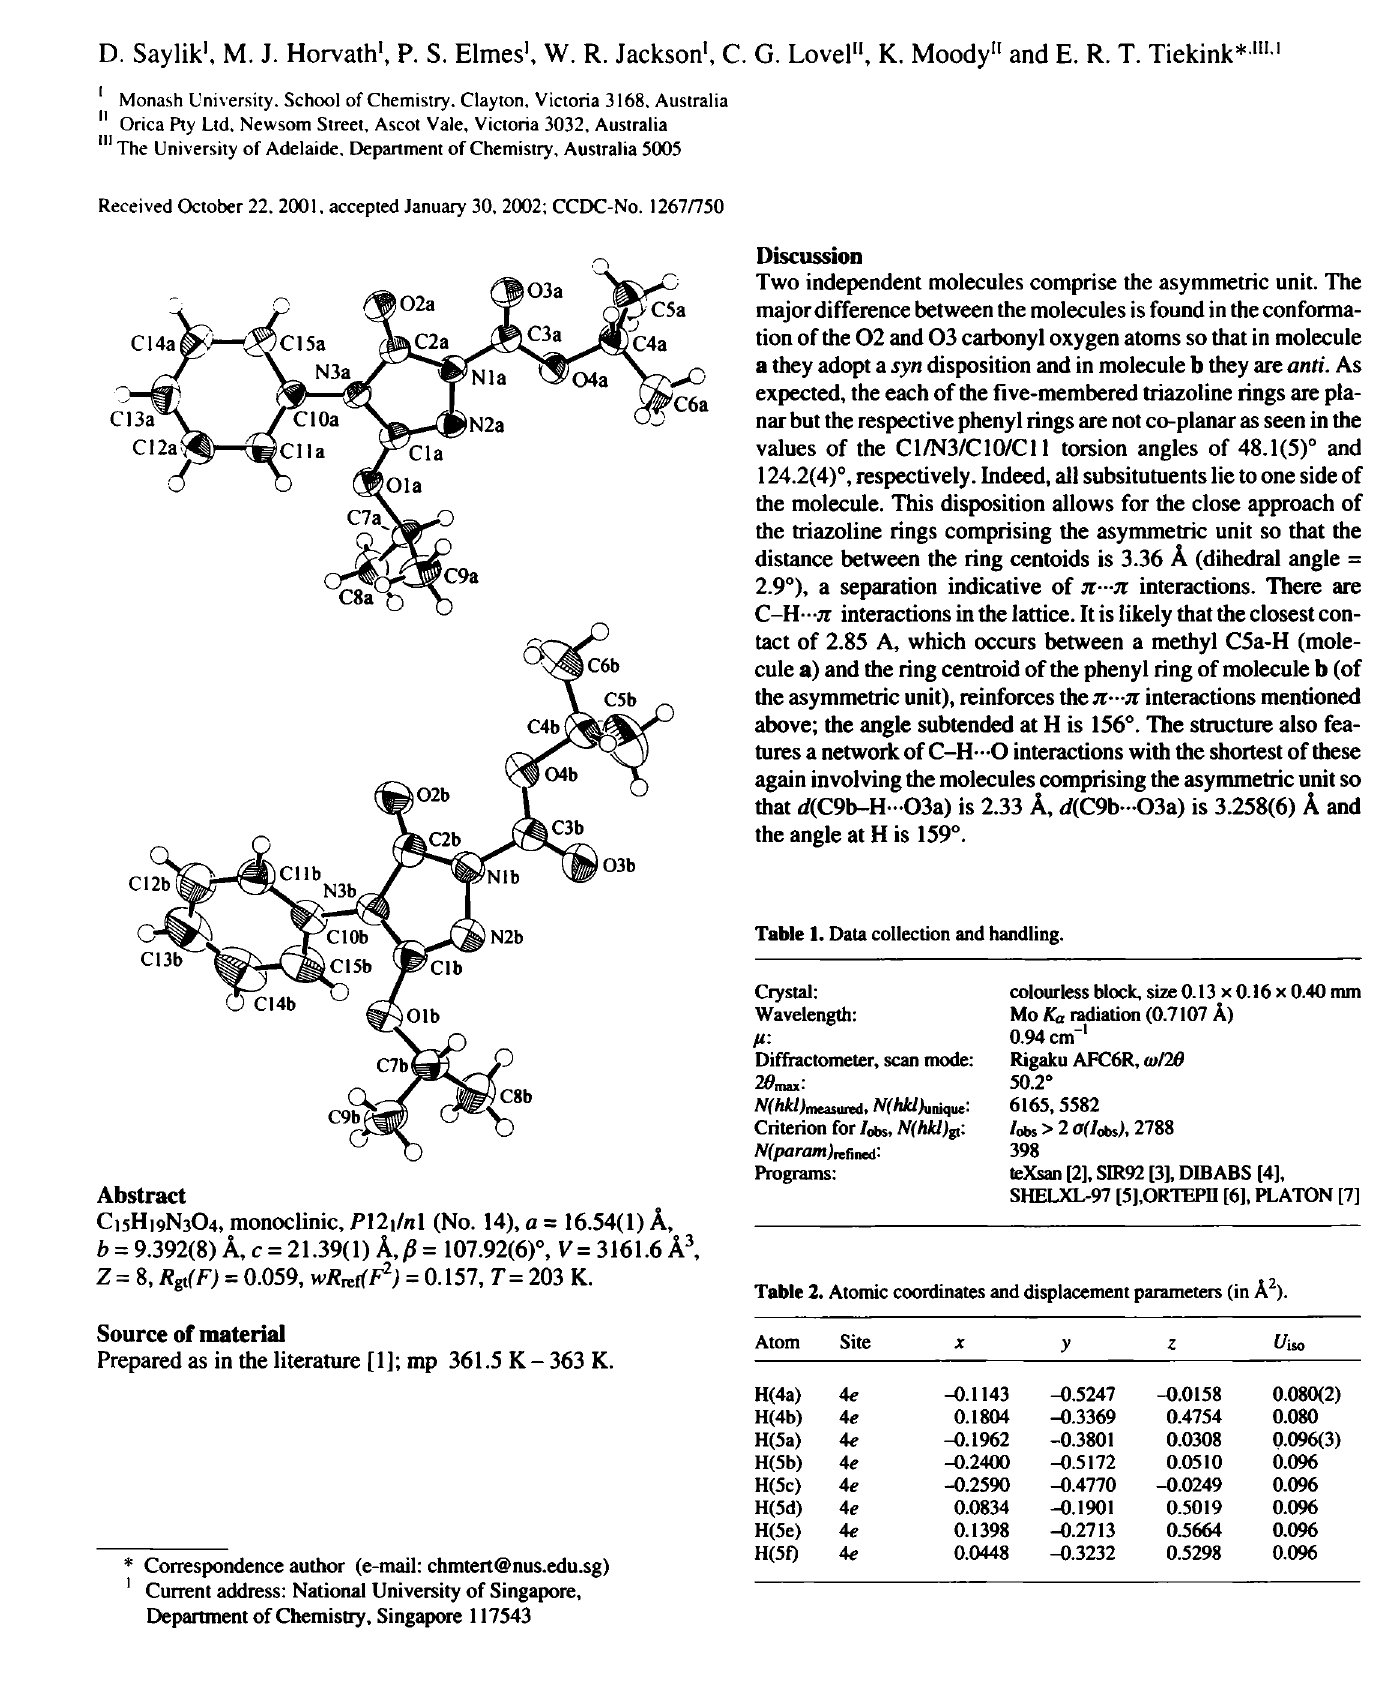
Table 2. Atomic coordinates and displacement parameters (in Â 2